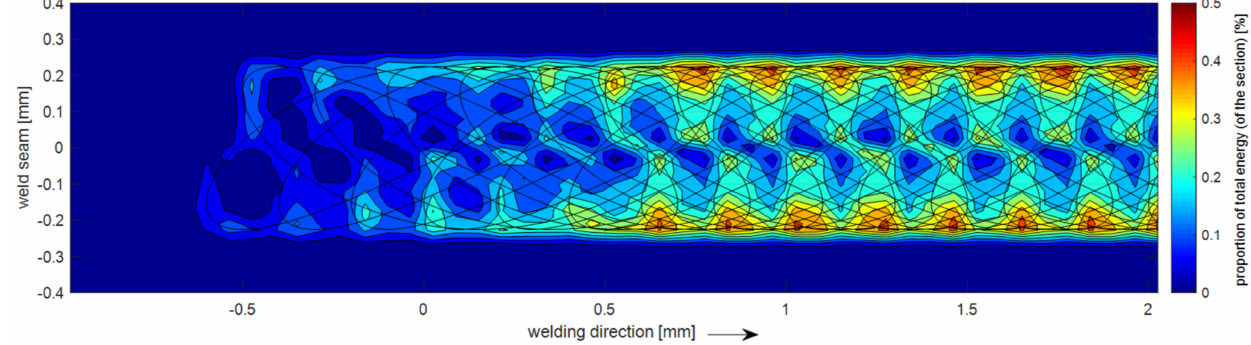
Figure 2. Relative energy distribution of the moving reference figure R starting on the left and reaching steady state on the right